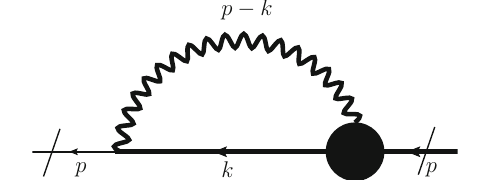
Fig. 8 The pictorial representation of the regularized fermion self- energy in Eq. (A.3), with the external legs amputated. The thick lines are the renormalized propagators of both the fermion and the photon, respectively, while the thin one is the free fermion propagator The full dot represents the renormalized interaction